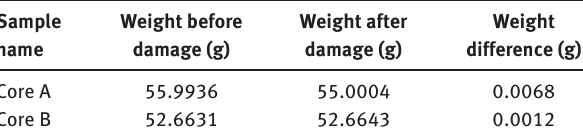
Table 5: Comparison of core weight before and after polymer flooding.